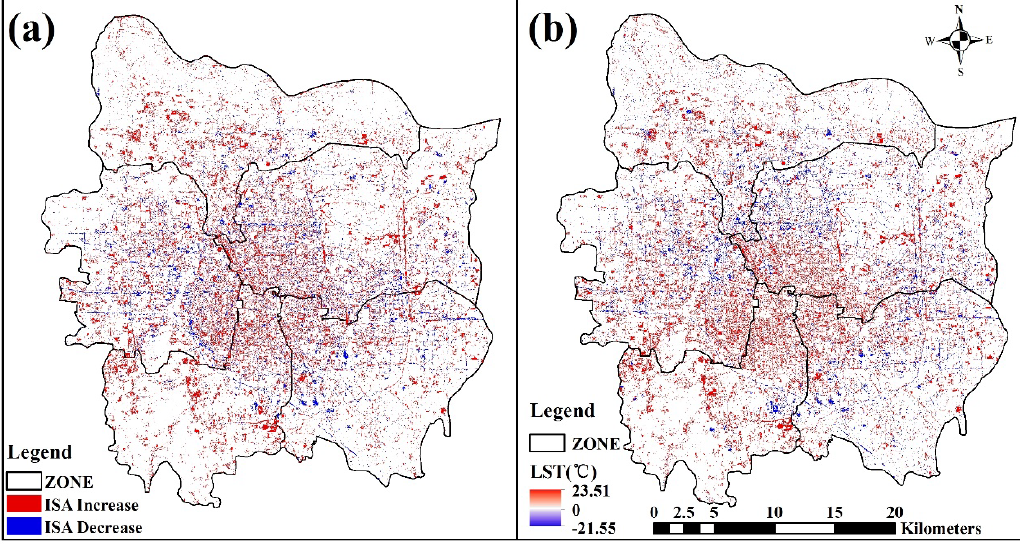
Figure 10. ISA changes and corresponding LST difference between 28 June 2013 and 20 June 2016. ( a ) The ISA regional changes generated by using the NDBI threshold method; and ( b ) the spatial distribution of LST difference.